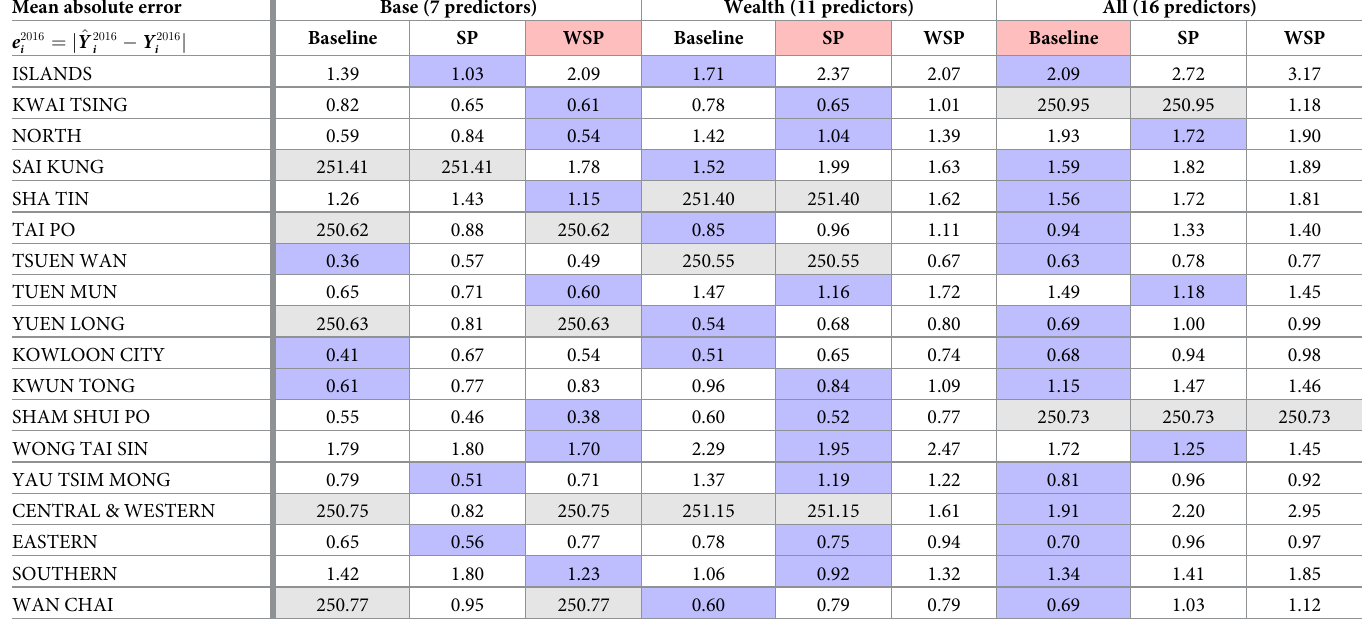
Table 2. Model evaluation by district. We report the mean absolute error for each model in 2016 averaged over a 1000 trials. The cells colored in blue show the model with the lowest margin of error for each district and feature category, whereas grey cells demonstrate ties among two models for a district. The model highlighted in red indicates the model with the lowest margin of error across all districts,